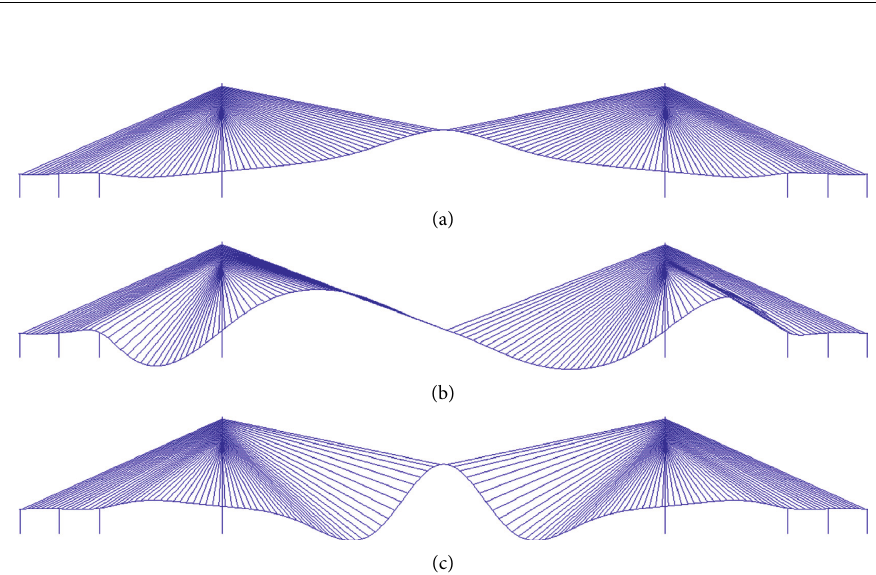
Figure 19: Modal shape diagrams of the top three orders (MIDAS model). (a) The first-order mode shape. (b) The second-order mode shape. (c) The third-order mode